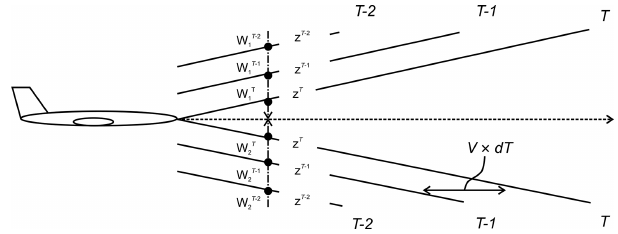
Figure 4. Overview of estimation by proposed method when line- of-sight wind data from 0, 1, and 2 past time steps d T are used. V is the speed of the aircraft; W T and W T are the wind speeds measured 1 2 at time T by the two lidars; z is the vertical distance perpendicular to velocity of the